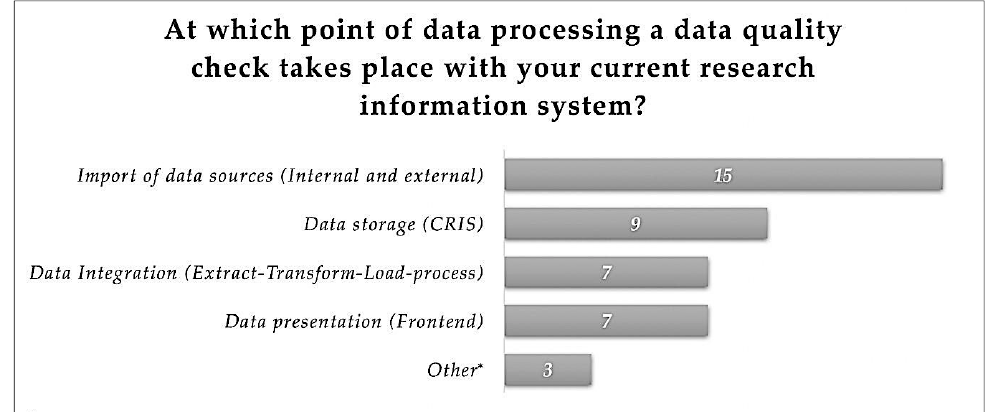
Figure 5. Point of data processing for data quality check in CRIS ( N = 17 ).